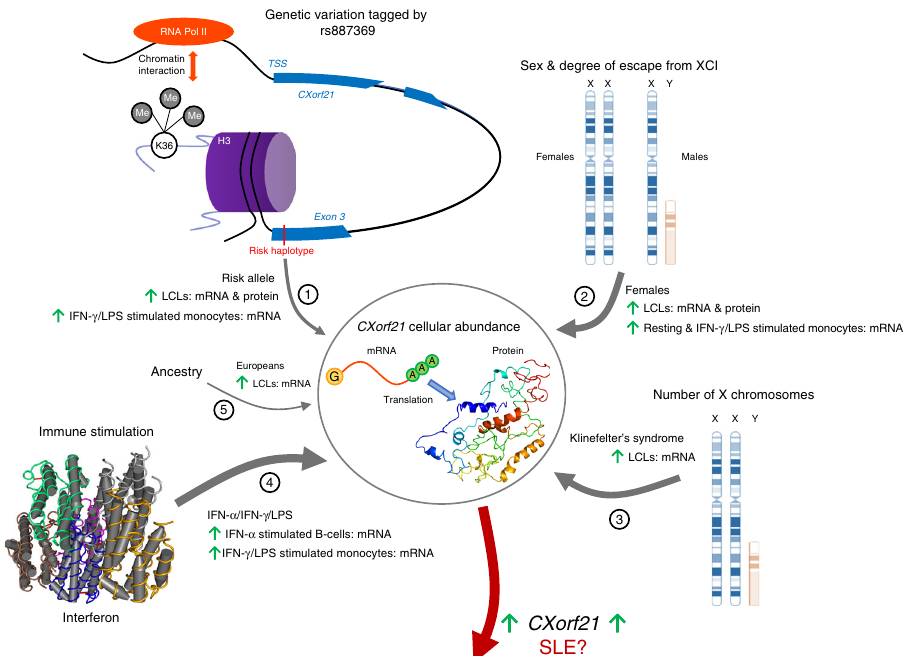
Fig. 8 Summary of factors in fl uencing expression of CXorf21 at RNA and protein level. We summarise fi ve factors increasing the cellular abundance of CXorf21 either at RNA level or protein level across a range of immune cell types. These are: (1) genetic variation at SLE susceptibility haplotype - tagged by SNP rs887369 - where the risk haplotype [C] may drive up-regulation by modulation of chromatin interaction and/or modi fi cation of H3K36me3 state; (2) female sex, in which escape from X-inactivation results in an increased amount of transcript and protein in females; (3) X chromosome aneuploidy; (4) type I and type II interferons, and LPS, increase the expression of CXorf21 in ex vivo B cells and monocytes; (5) ancestry – potentially linked to the minor allele frequency of rs887369 – in which higher levels of CXorf21 transcript is observed in LCLs derived from donors with European ancestry. We hypothesise that elevation of CXORF21 is a risk factor for developing SLE and that this is may be mediated through it ’ s role in the endosomal pathway. Figure generated by